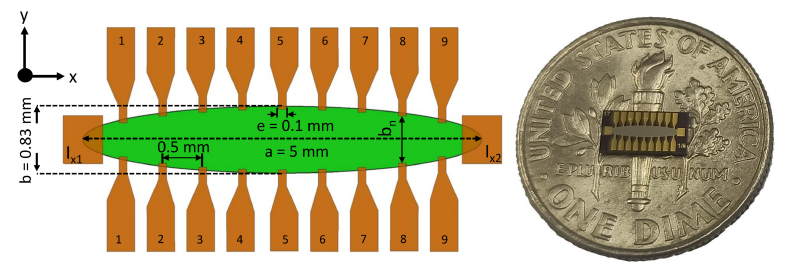
Figure 1. ( left ) Schematics of EPHEG geometry (not to scale). The orange regions are gold electrical contact pads. The long and short axes of the ellipse are labeled as a and b , respectively. The sensor is excited between I x 1 and I x 2 , and the transverse signal is measured across any of the parallel 9 voltage pairs (marked from 1 to 9). b n is the distance between voltage pairs n . ( right ) Photograph of a sensor on a dime as a size